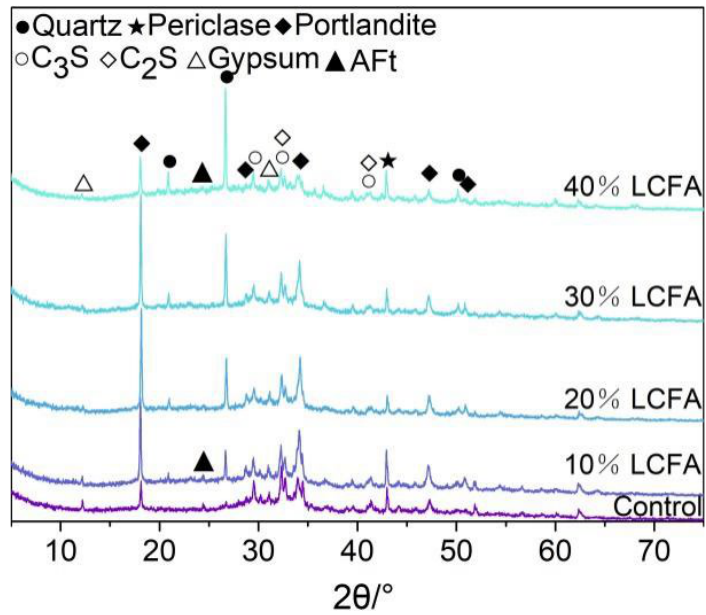
Figure 12. XRD patterns of OPC-LCFA sample at 28 days.